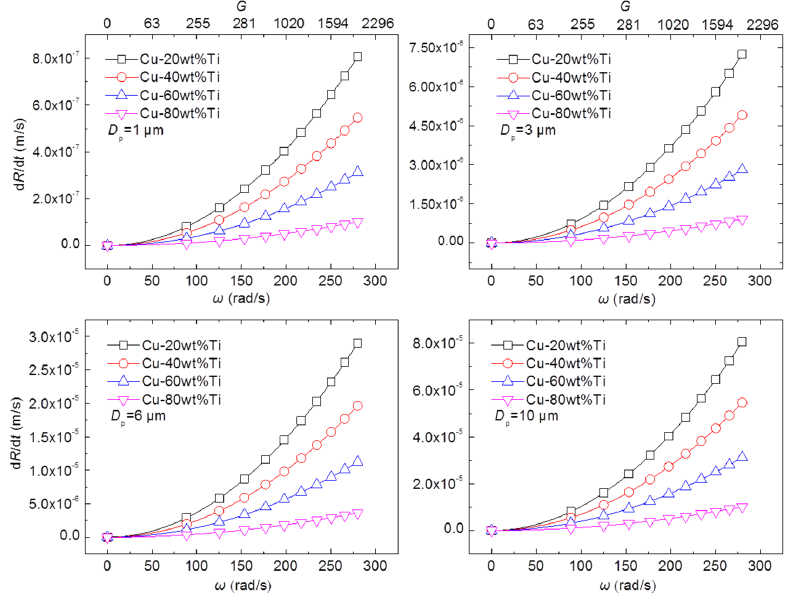
Figure 6. The correlation between the TiC x particle floating speed in the Cu-Ti melt and the centrifugal velocity (super gravity coe ffi cient G ).